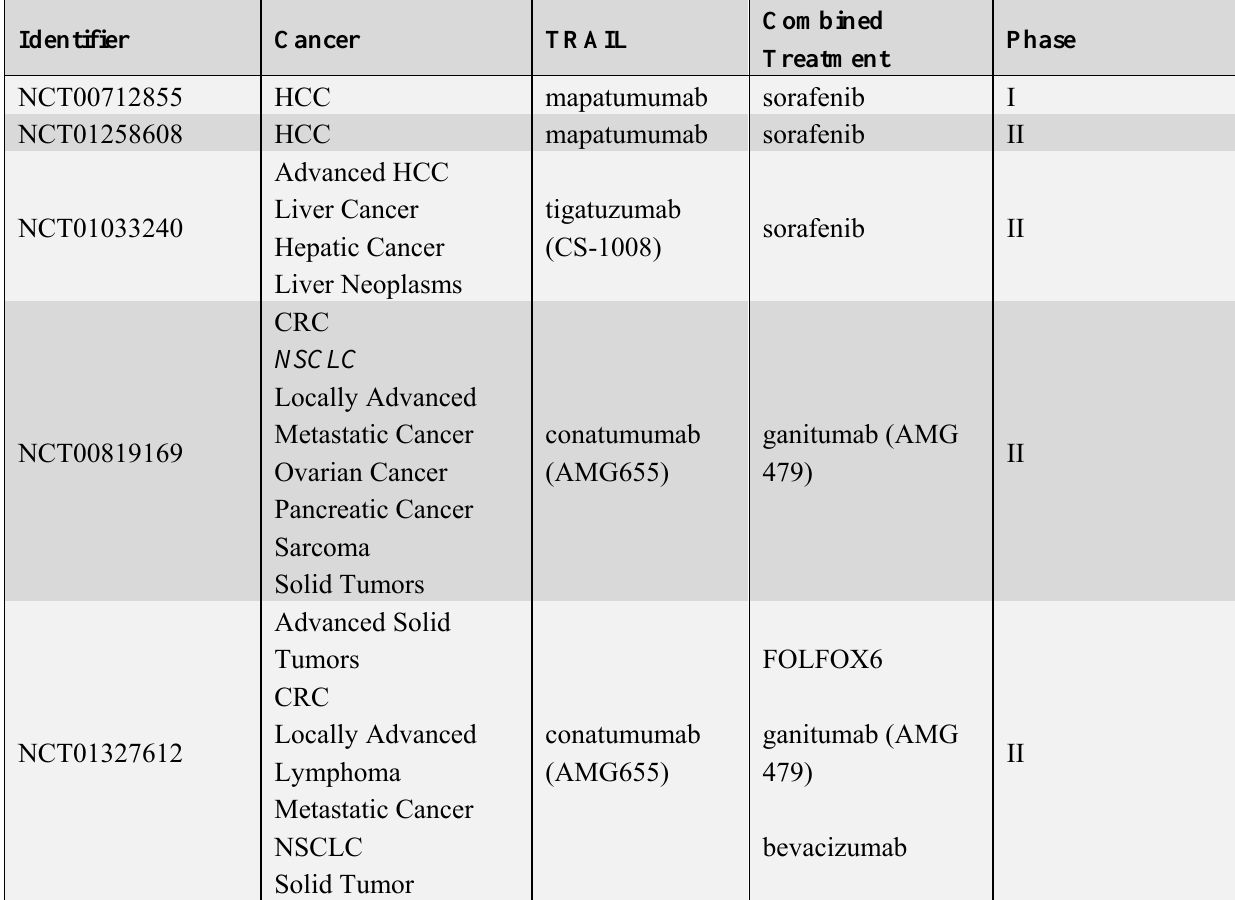
Table 3. TRAIL based combined clinical trials.